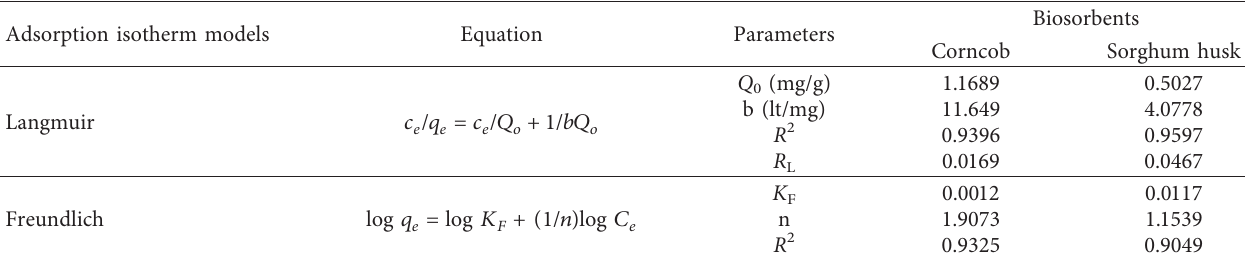
Adsorption isotherm